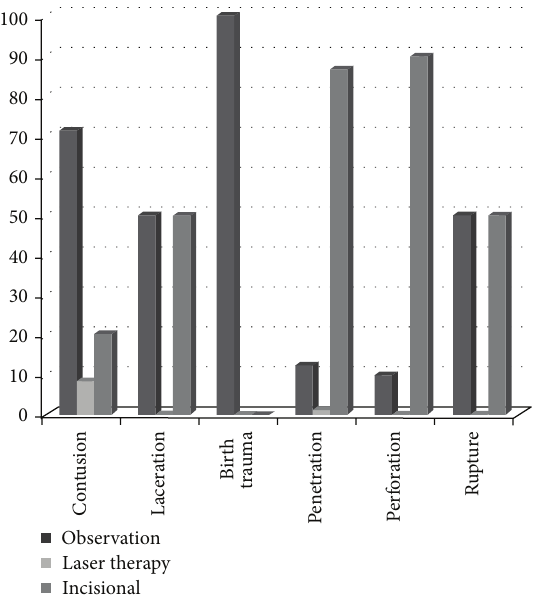
Figure 2: Management modalities used in different types of vitreous hemorrhage caused by accidental